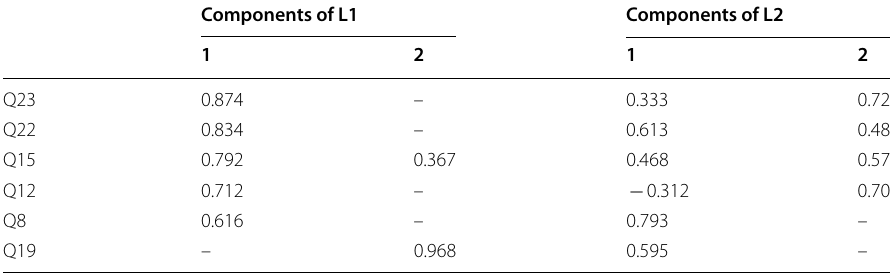
Table 9 Component matrix for L1 and L2 Use in General Components of